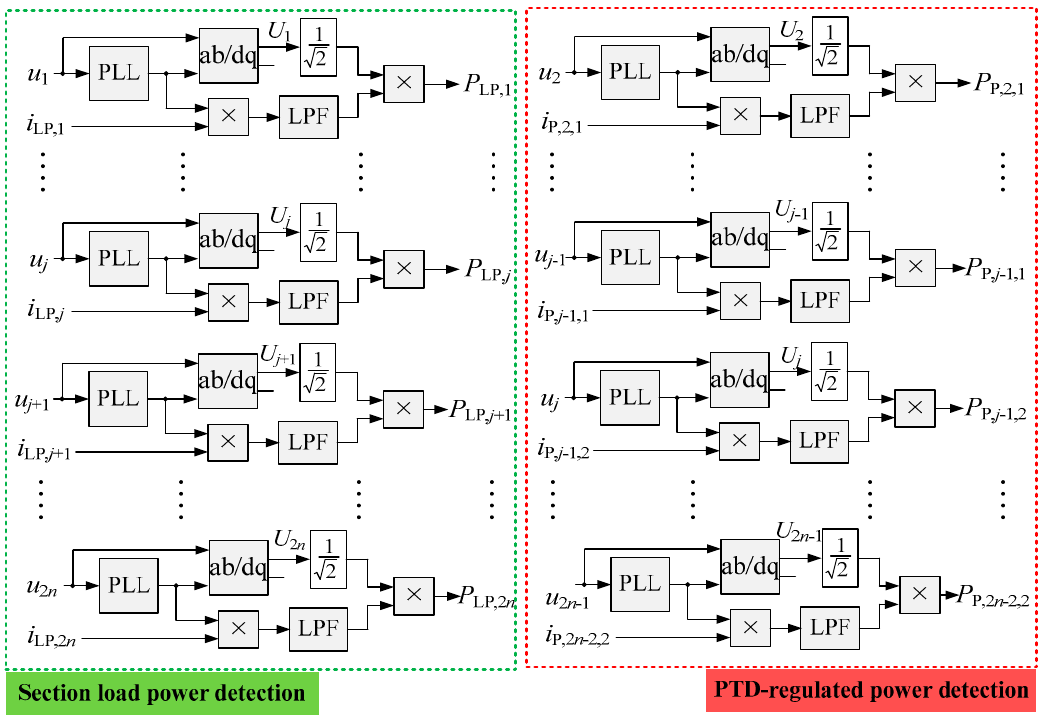
Figure 13. Detection block diagram of section load power and PTD-regulated power in centralized control. PLL: phase locked loop; LPF: low pass loop .